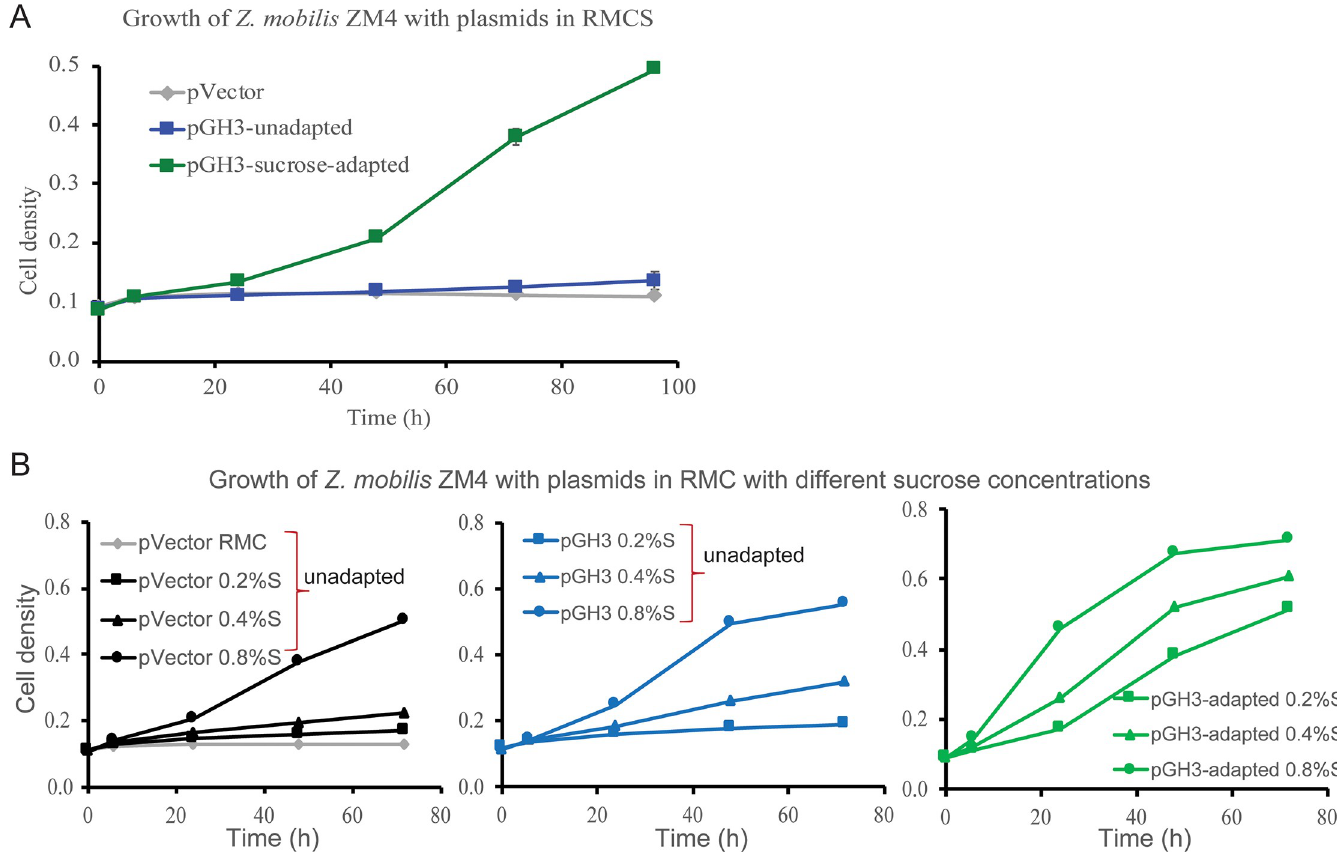
Fig 4. Sucrose adaptation allows Z . mobilis GH3 to grow on cellobiose. (A) Growth of sucrose-adapted Z . mobilis GH3, pVector control, and unadapted Z . mobilis GH3 in RMC supplemented with 0.1% sucrose (RMCSuc). (B) Growth of sucrose-adapted and unadapted Z . mobilis GH3 and pVector control, in RMC plus sucrose (0.2–0.8%). Gray line, Z . mobilis pVector RMC alone. Black lines, Z . mobilis + pVector in RMC+sucrose. Blue lines, Z . mobilis GH3 in RMC+sucrose. Green lines, sucrose-adapted Z . mobilis GH3 in RMC+sucrose.